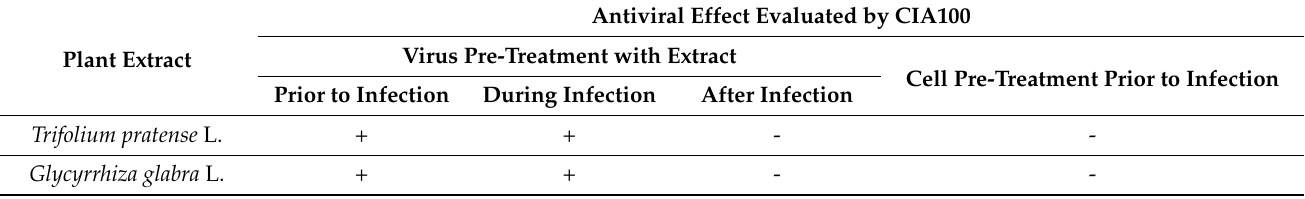
Table 6. Antiviral activity of plant